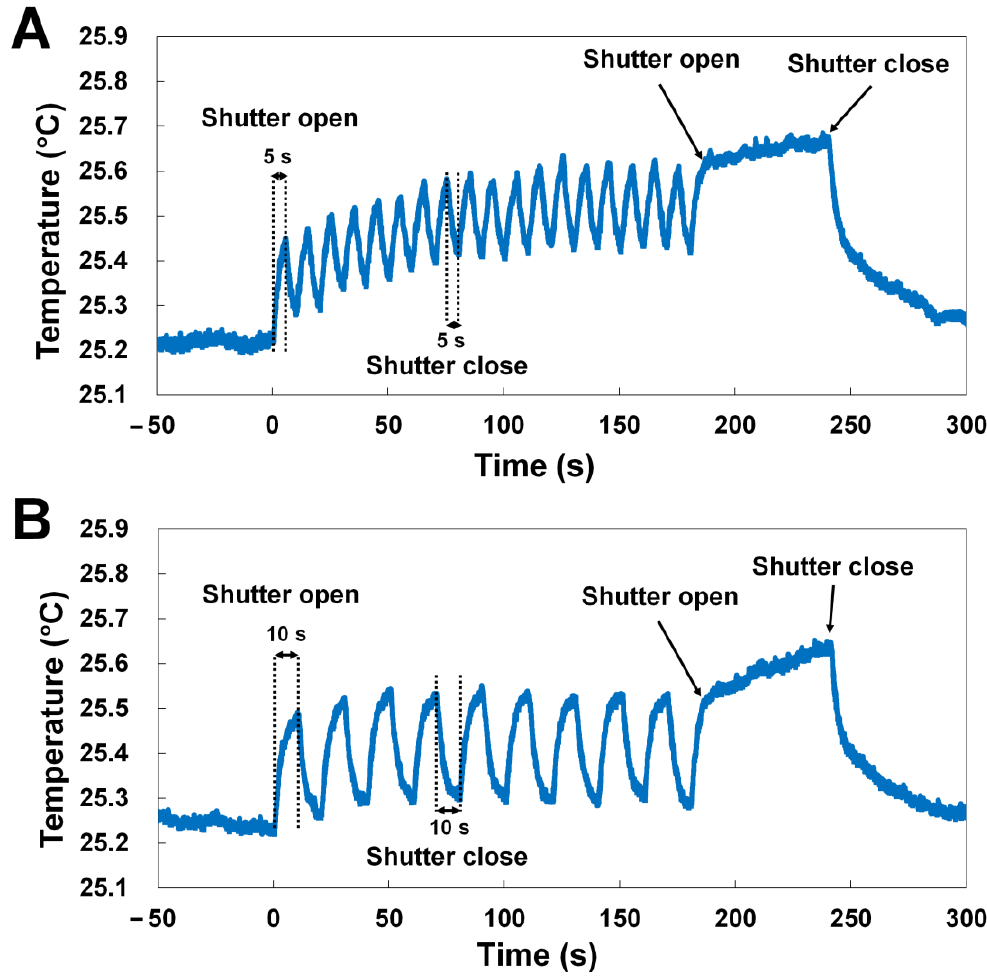
Figure 5. Temperature change measurement in the vicinity of the X-ray interaction point under repeated X-ray exposure and non-exposure for ( A ) 5 s and ( B ) 10 s.